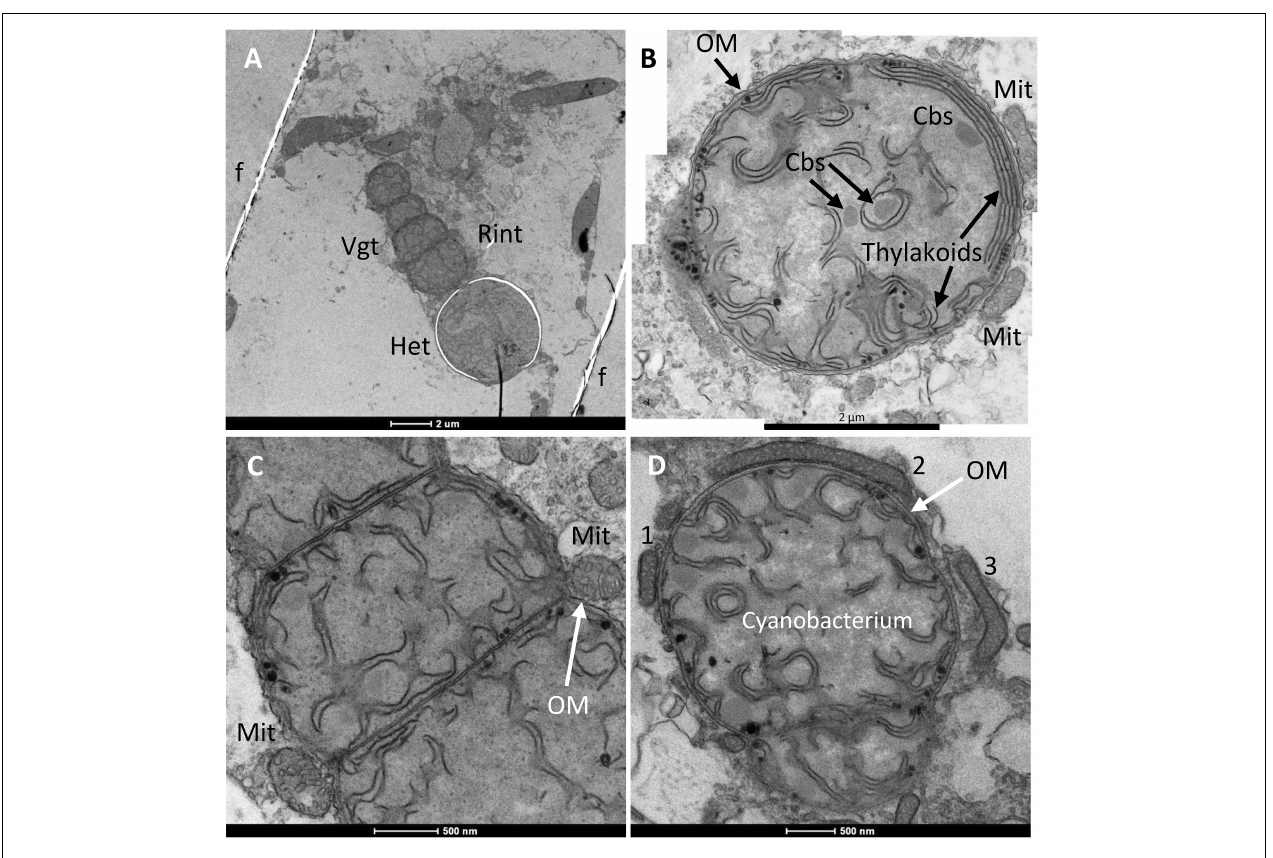
FIGURE 4 | Transmission electron micrograph of mitochondria and R. intracellularis in the cytoplasm of H. hauckii . (A) Longitudinal section of a R. intracellularis filament (Rint) composed of one terminal heterocyst (Het) and four vegetative cells (Vgt). The cyanobacterial filament is located within a diatom cell; f, frustule. (B) Transverse section of a cyanobacterial cell with mitochondria (Mit) next to the outer membrane (OM). Note also the presence of carboxysomes (Cbs) and thylakoids (intracellular membranes) in the cyanobacterium. (C) Magnified view of a section of the filament from panel (A) containing vegetative cells and mitochondria (Mit) nearby; OM, outer membrane. (D) Transverse section of a R. intracellularis cell showing nearby mitochondria (some indicated by numbers, 1–3). Note that mitochondria 1 and 2 are tightly associated to the outer membrane of the cyanobacterium, whereas mitochondrion 3 is not bound to the